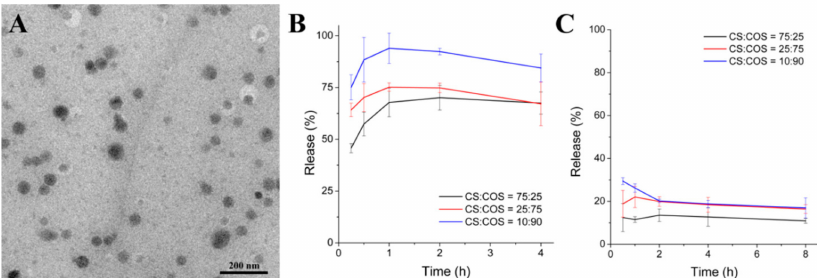
Figure 3. The release of SeNPs from SeNPs-CS / COS-Ms in simulated gastric fluid (SGF) and simulated intestinal fluid (SIF). ( A ) A typical TEM image of the released SeNPs in SGF or SIF. ( B , C ) The relative release rates of SeNPs from SeNPs-CS / COS-Ms with di ff erent material ratios of CS:COS (75:25, 25:75, and 10:90) in ( B ) SGF and ( C ) SIF.